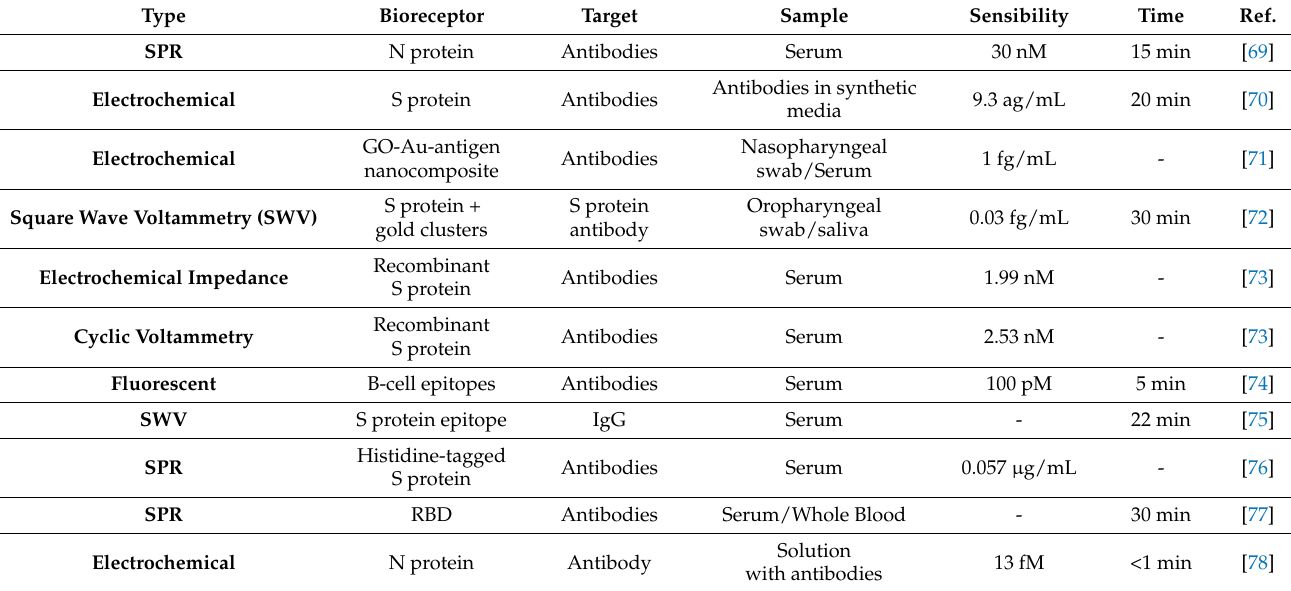
Table 3. Potentially useful biosensing methods targeting SARS-CoV-2 antibodies (SPR—Surface plasmon resonance; GO—graphene